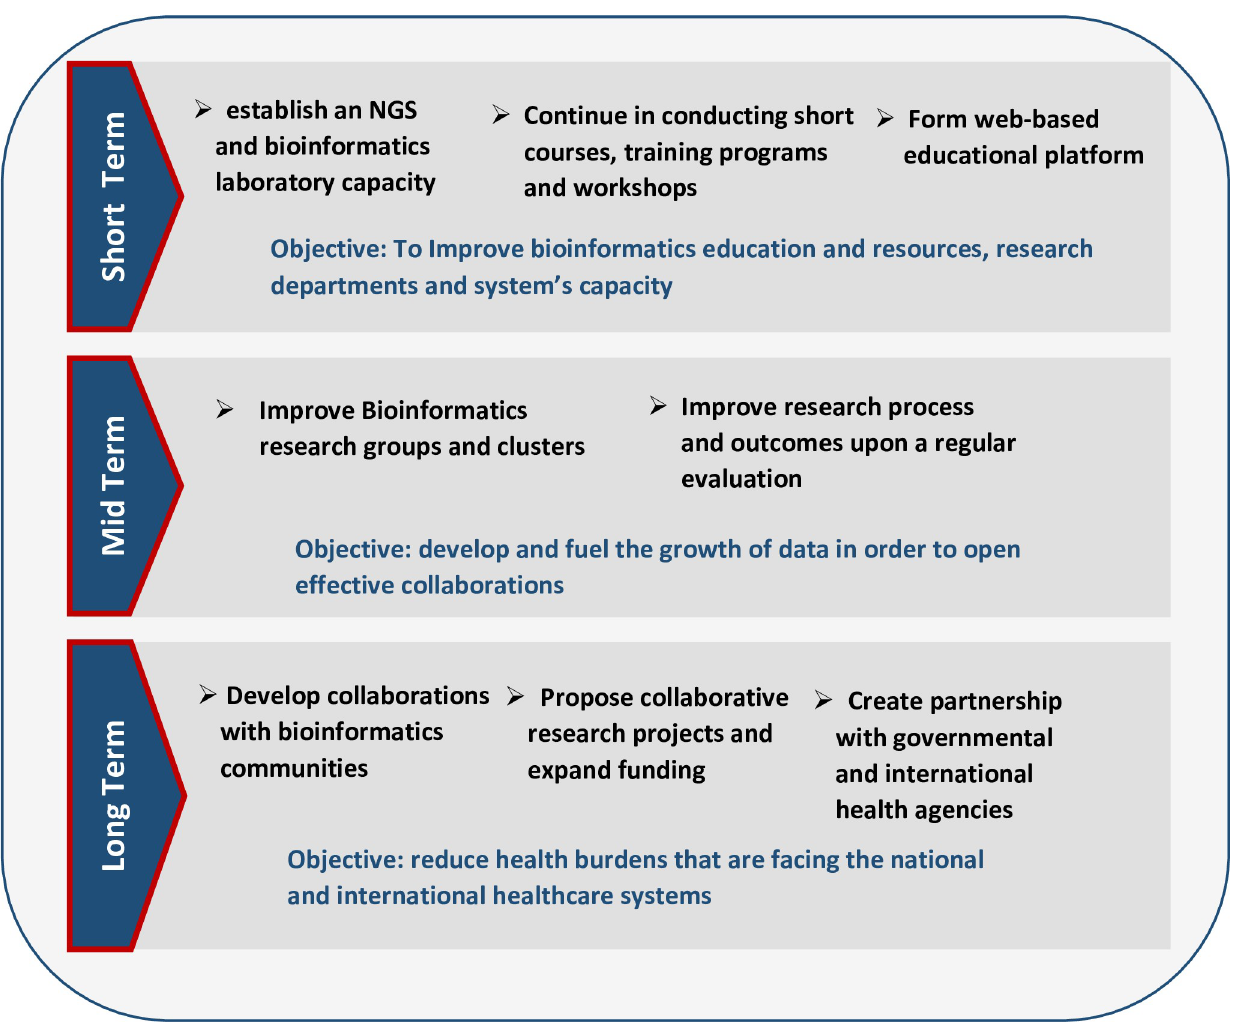
Fig 3. Proposed strategies for promoting bioinformatics in NUBRI. NGS, next generation sequencing; NUBRI, National University Biomedical Research